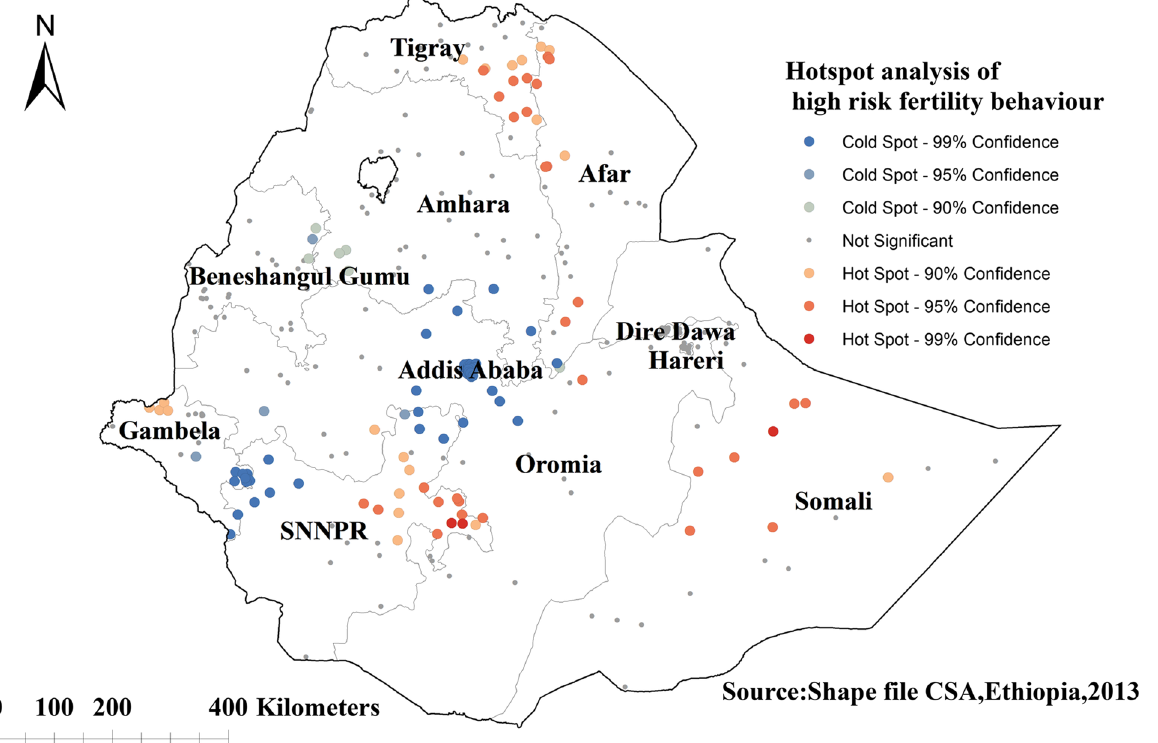
Fig. 3 Hot spot analysis of high-risk fertility behavior among reproductive-age women in Ethiopia, 2019 Ethiopian Demographic and Health